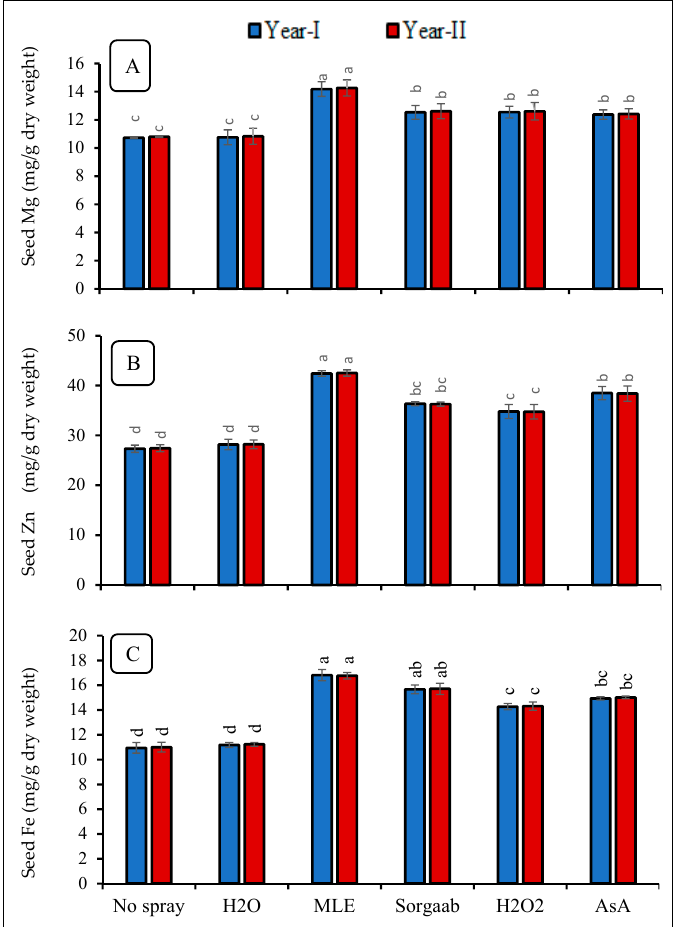
Figure 4. Influence of plant growth promoters on seed magnesium (A), zinc (B), and iron (C) of quinoa cultivated during the growing seasons of 2016–2017 and 2017–2018. Bars sharing the same letter did not differ significantly at P = 0.05.